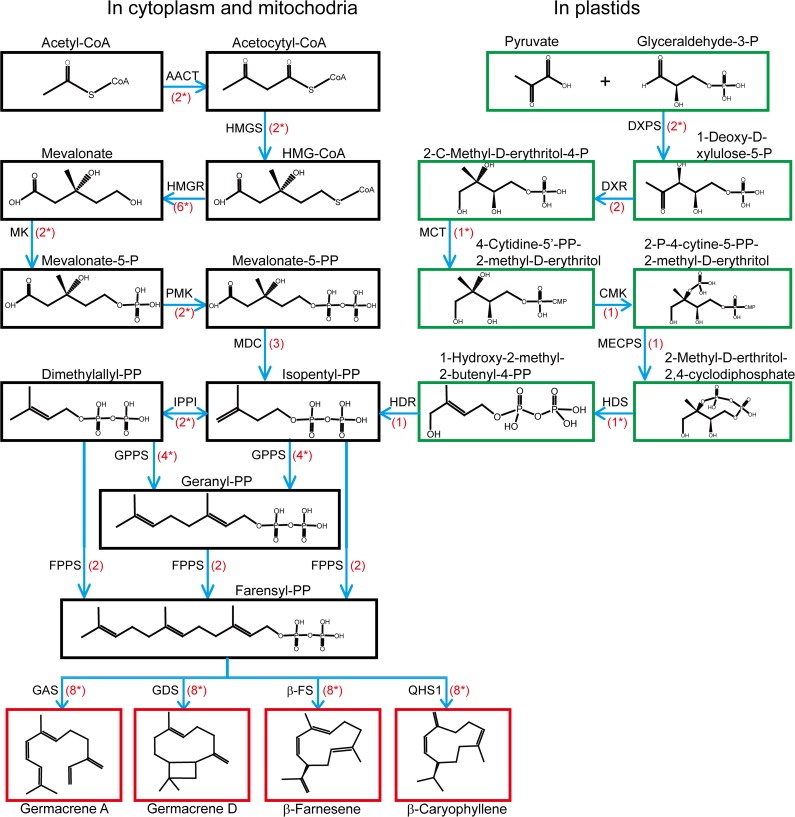
Putative sesquiterpenoid biosynthetic pathway in Atractylodes lancea.A flow diagram of biosynthetic pathway of terpenoid backbone and sesquiterpenoids biosynthesis in Atractylodes lancea. The structures of chemicals in the pathway are shown in boxes. The green boxes represent the plasticidal pathway while the black boxes show the pathway in cytoplasm & mitochondria. The words on the boxes are enzymes for the reaction while the numbers in red color represent the number of transcripts for that specific gene. Reactions in cytoplasm, mitochondria and plastids are shown in green. The boxes with red border show the structure of various sesquiterpenoids of A. lancea.